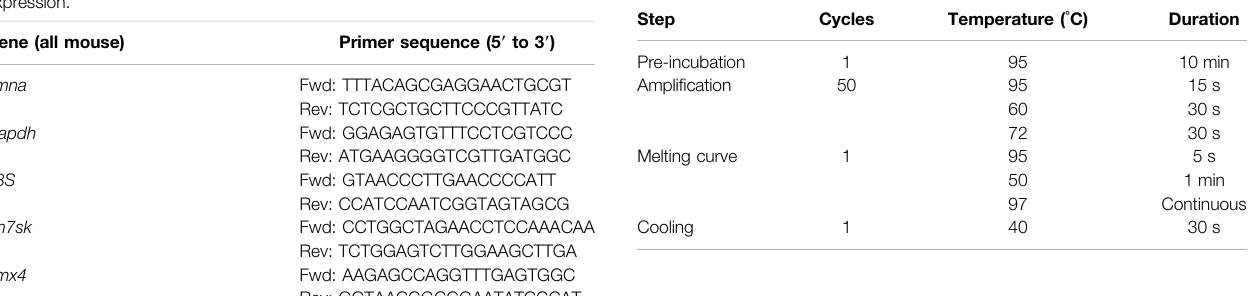
TABLE 1 | List of primers used for quantitative Real-Time PCR analysis of gene expression. Gene (all mouse)